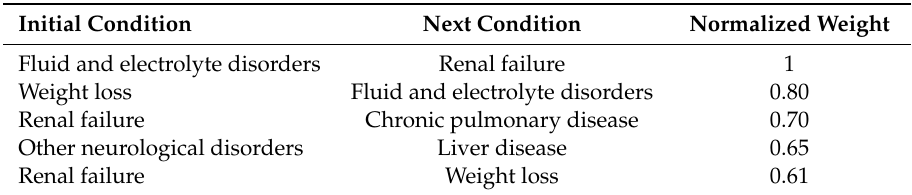
Table 6. Top five most prevalent transitions between comorbidities in the final disease network.